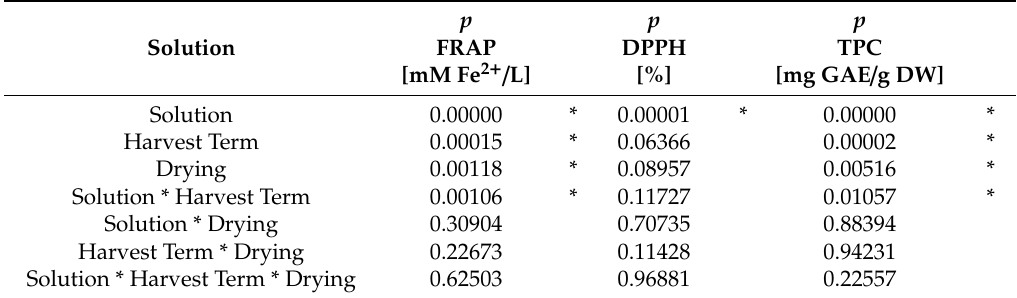
Table 3. ANOVA results for FRAP, DPPH and TPC parameters in samples of sage leaves collected in June and July.